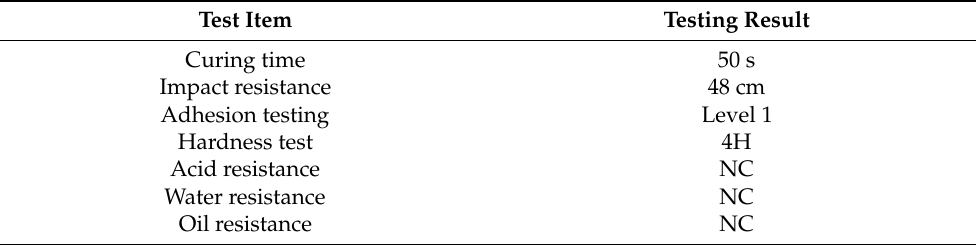
Table 2. Properties of the composite